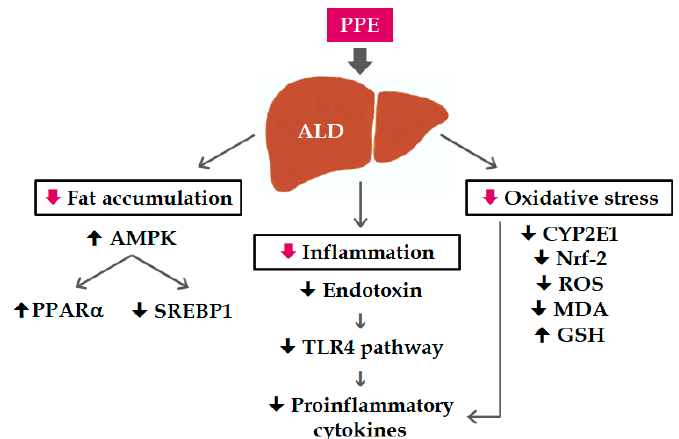
Figure 5. Possible mechanisms of the hepatoprotective effects of PPE on mice with alcoholic liver disease.